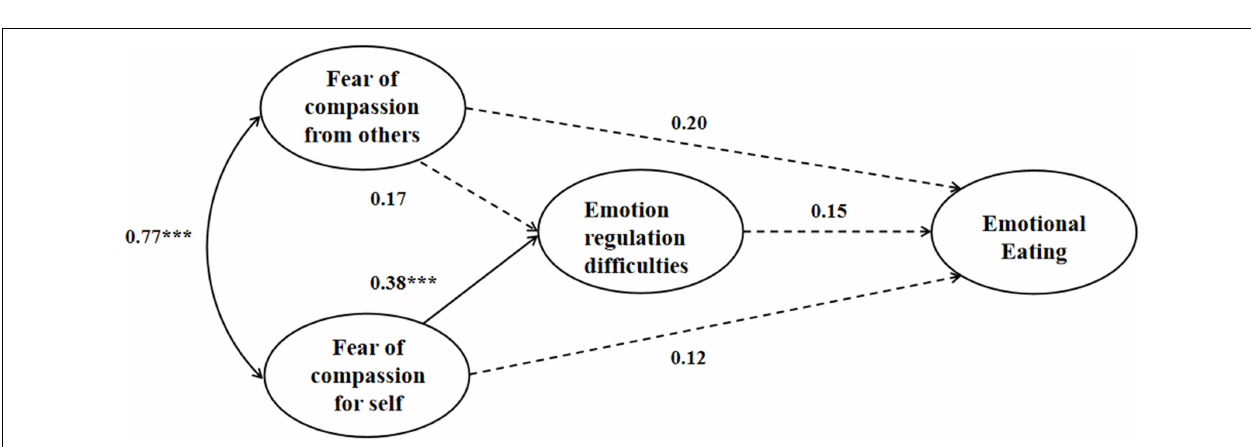
FIGURE 2 | The mediation model of the study variables for male students; standardized coefficients are presented; * p < 0.05; ** p < 0.01; *** p < 0.001.